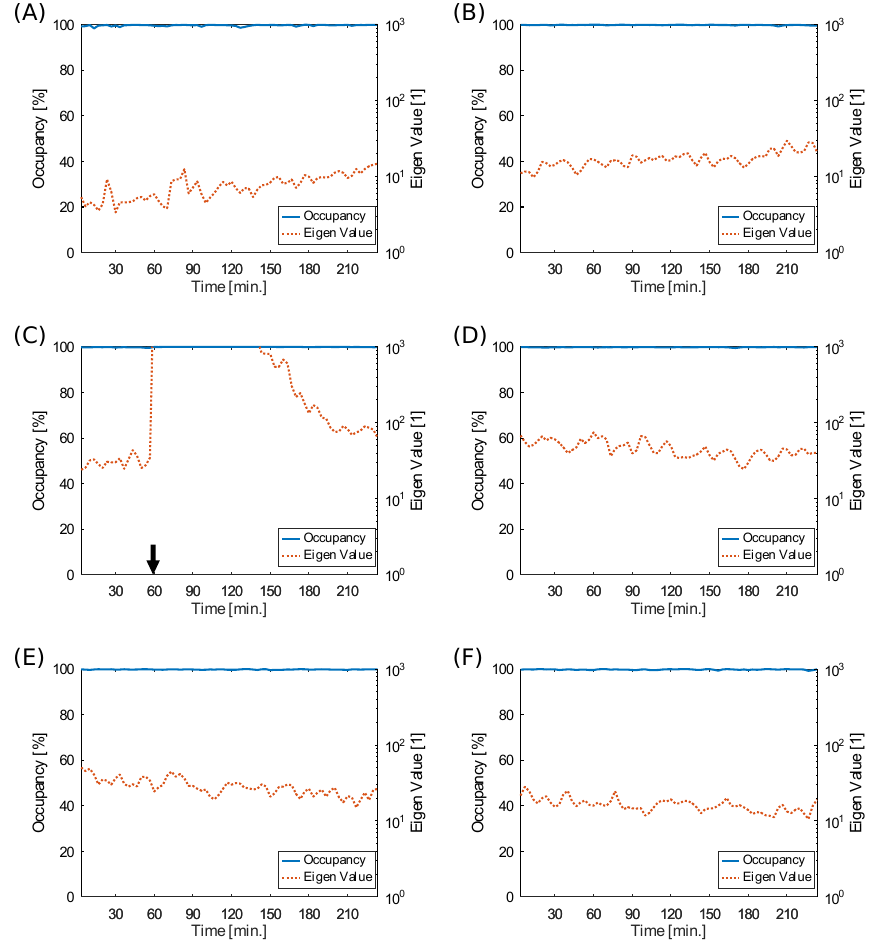
Figure 11. Occupancy rate and the first eigenvalue around the Fukushima earthquake for ( A ) 2016/326/12-16, ( B ) 2016/326/16-20, ( C ) 2016/326/20-24, ( D ) 2016/327/00-04, ( E ) 2016/327/04- 08, ( F )